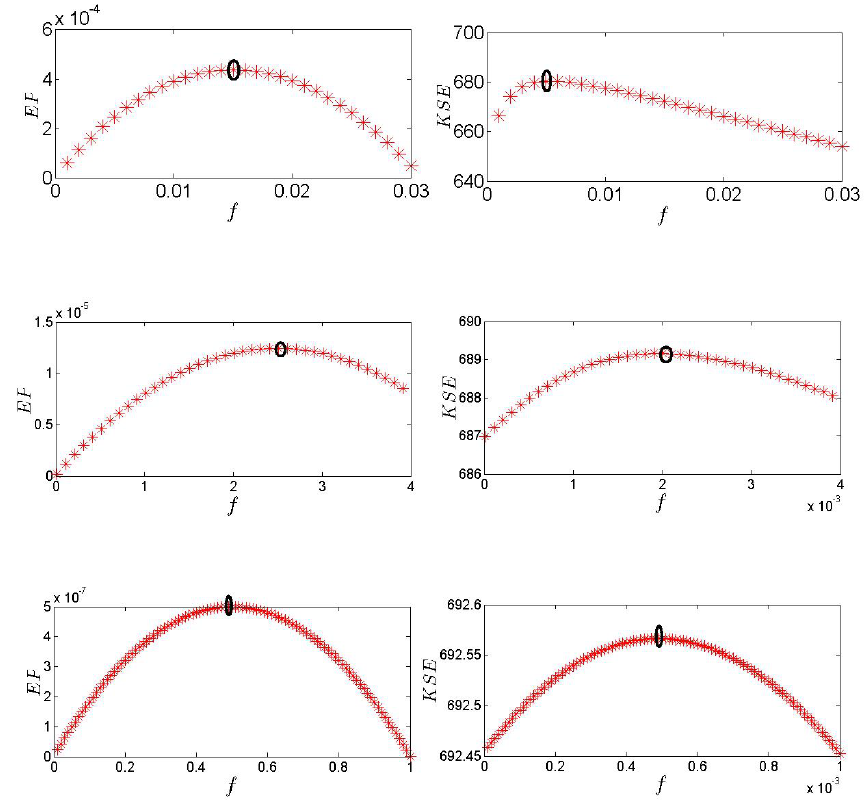
Figure 2. Entropy production (left) and KS entropy (right) as functions of f for N = 1000 and respectively s = 0 . 13, s = 0 . 2 and s = 0 . 04.